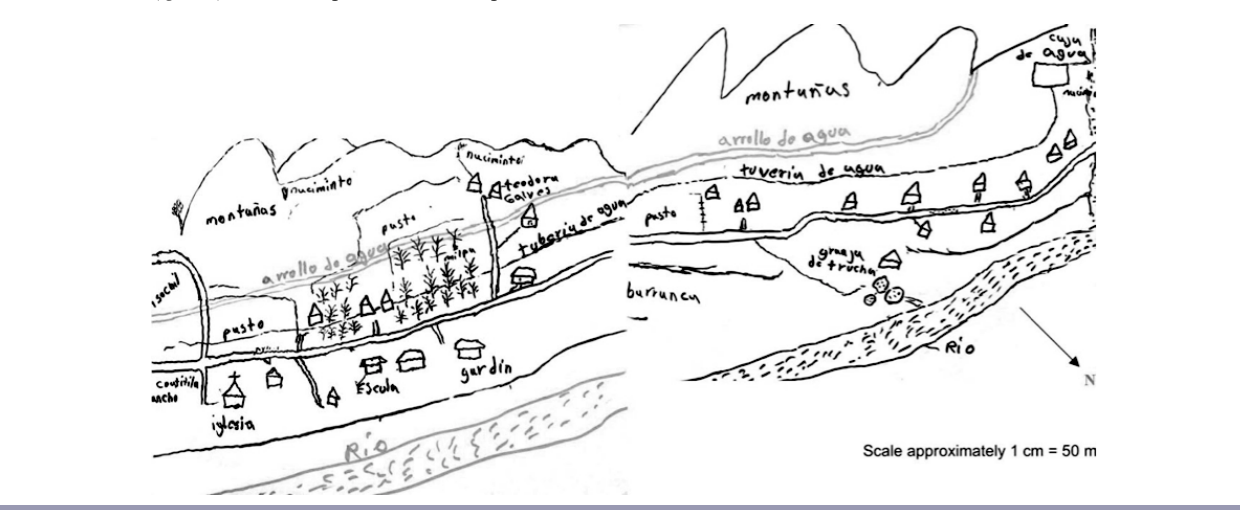
Fig. 3 . Map of Coatitilán drawn by Juan Galvez (2007). The backdrop is characterized by mountains ( montañas ), with two springs ( nacimientos ) identified. A large stream ( arrollo de agua ) flows from the mountains in the southwest to the east. A reservoir ( caja de agua ) is higher up on the hillside to the west of the community. Previous to the road construction, the water was distributed throughout Coatitilán by tubing ( tubería de agua ). Interspersed between the houses, as drawn in part of the community, are corn–bean fields ( milpa ) and pastures ( pasto ). Adjacent to the river ( río ) is the trout cultivation basin ( granja de trucha ). The ravine along the river ( barranca ) is to the west of the trout cultivation basins. The school ( escuela ), kindergarten ( gardin ), and church ( iglesia ) are also depicted on the